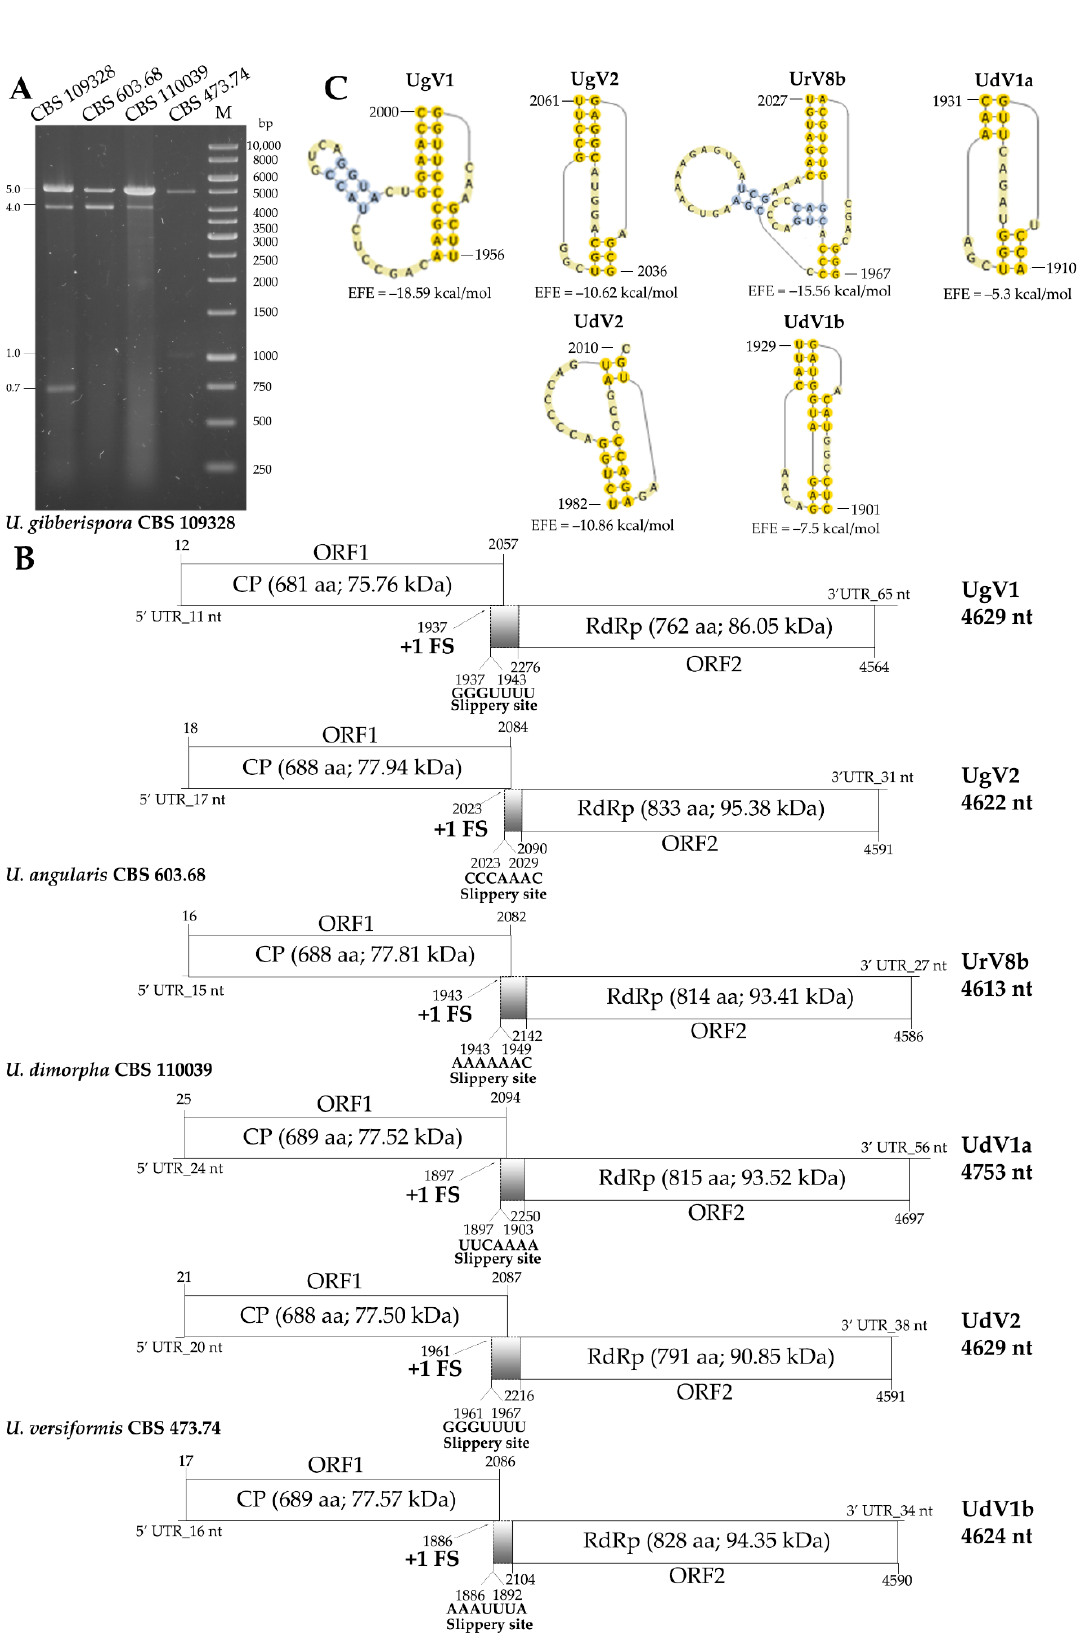
Figure 3. Gel electrophoresis pattern and genomic organization of the detected dsRNA genomes in three mycovirus-harboring Umbelopsis strains. ( A ) Agarose gel electrophoresis of dsRNA fragments purified from the mycovirus-harboring Umbelopsis strains. Lane 1, Umbelopsis gibberispora CBS 109328; Lane 2, Umbelopsis angularis CBS 603.68; Lane 3, Umbelopsis dimorpha CBS 110039; Lane 4,